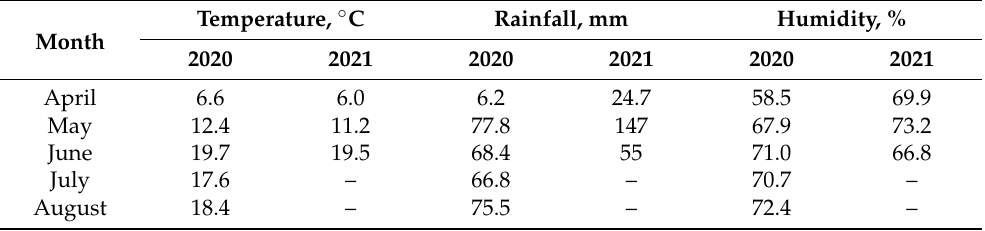
Table 1. The meteorological data of Vilnius meteorology station in the period April–August in 2020 and in the period April–June in 2021 (– denotes unanalyzed meanings, because the experiment was completed in June in